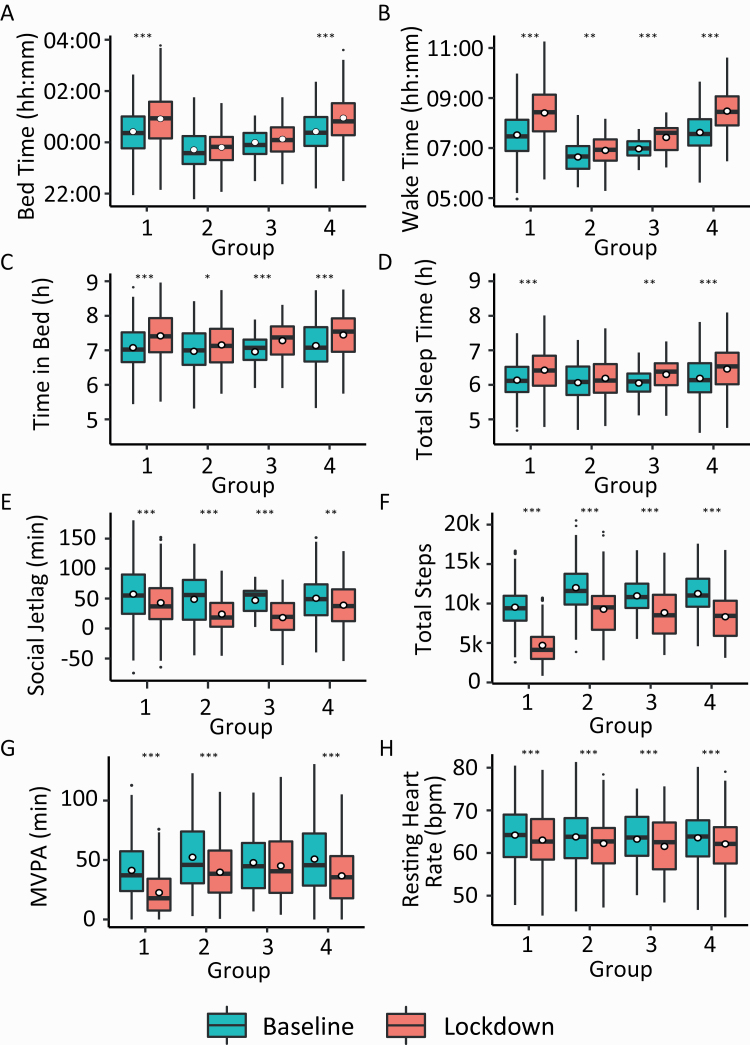
Boxplots for comparisons between groups identified by the hierarchical clustering, during the “Baseline” and “Lockdown” period. (A) Bedtime, (B) Waketime, (C) TIB, (D) TST, (E) SJL, (F) Step counts, (G) Time spent in MVPA, and (H) Resting heart rate. Asterisks denote significant pairwise comparisons between “Baseline” and “Lockdown” periods for each group. *p < 0.05, **p < 0.01, ***p < 0.001.